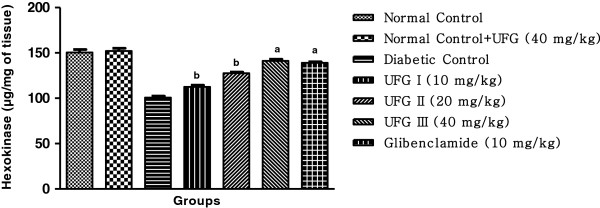
Effect of umbelliferone β-D-galactopyranoside on level of Hexokinase at different concentrations on STZ induced diabetic rats, compared to diabetic control group rats; values are mean ± SEM; n = 6;
c
P < 0.05;
b
P < 0.01;
a
P < 0.001; P > 0.05 is considered as non-significant (ns).